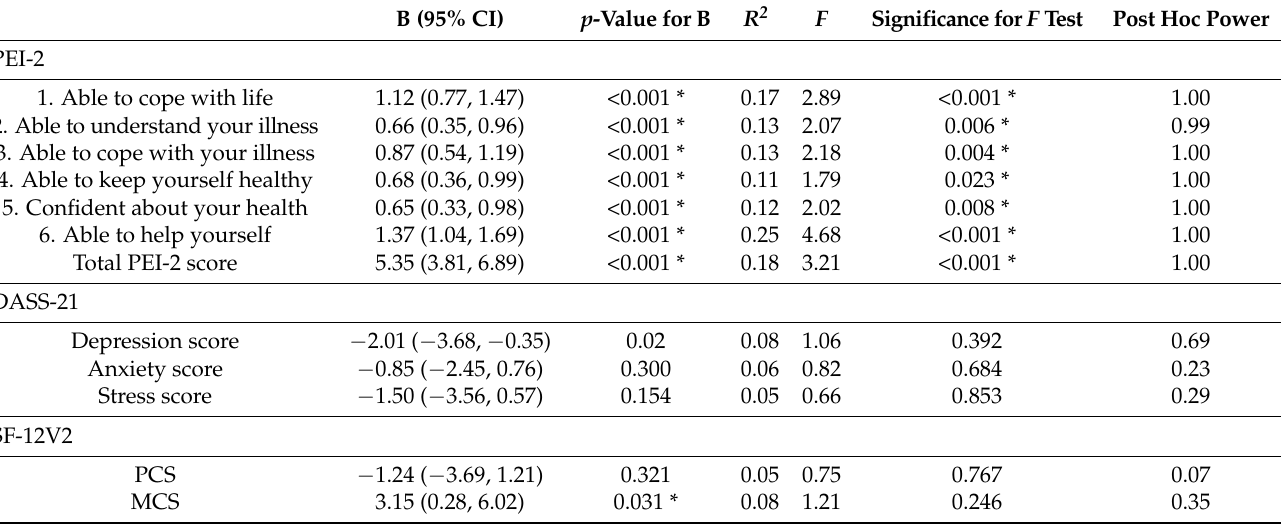
Table A3. Associations between health empowerment program participation and changes in out- comes at 5 year follow-up before propensity score